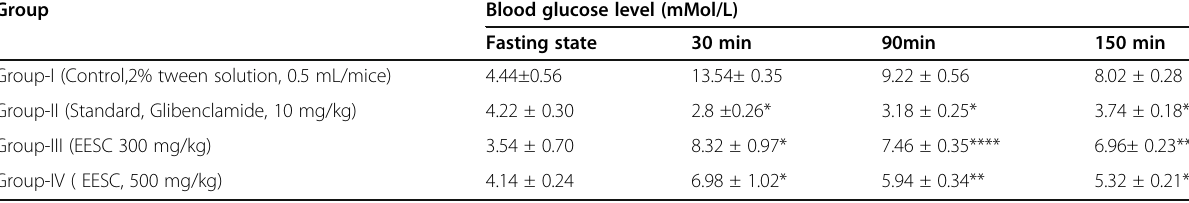
Values are expressed as mean ± standard error of mean ( n = 6) EESC Ethanolic extract of S. caseolaris (L.) Engl *indicates p <0.0001 compared with control ** indicates p <0.001 compared with control